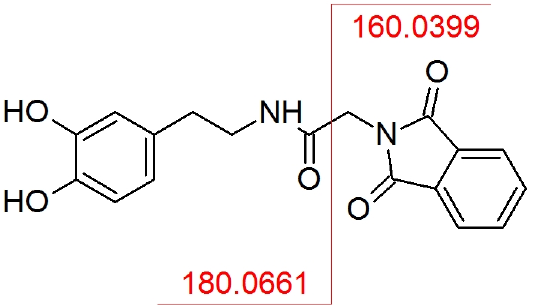
Figure 5. Possible fragmentation method of the most abundant product ion ( m / z 160.0393) for inves- tigated analytes on dopamine example.